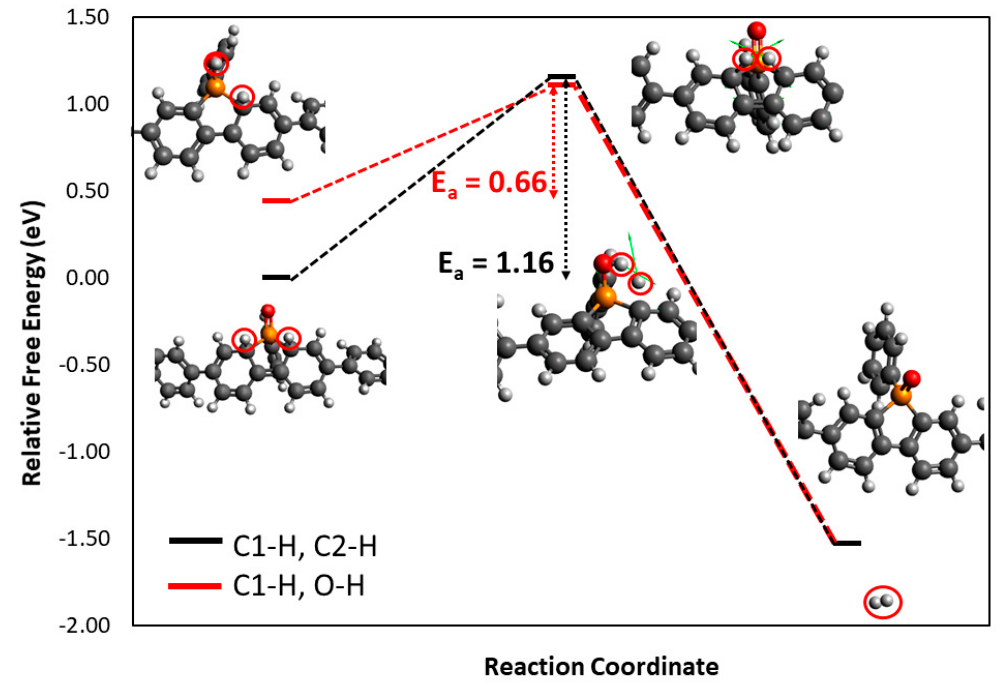
Figure 7. Energy diagram of intramolecular H 2 formation using the PCzPO D-A moiety model protonated at C1 and C2 (red line) and C1 and O (black line), computed by DFT.